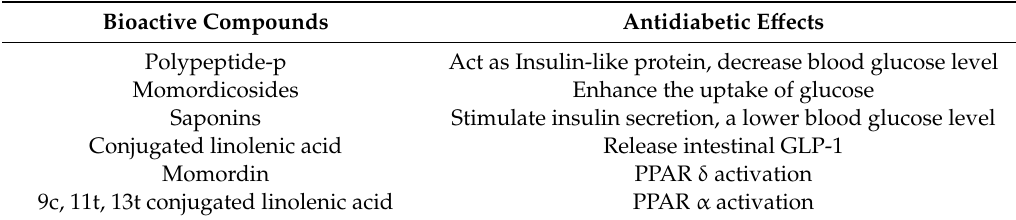
Figure 4. The mechanism in decreasing blood glucose levels of M. charantia. Table 1. Bioactive compounds and their effects in Momordica charantia.